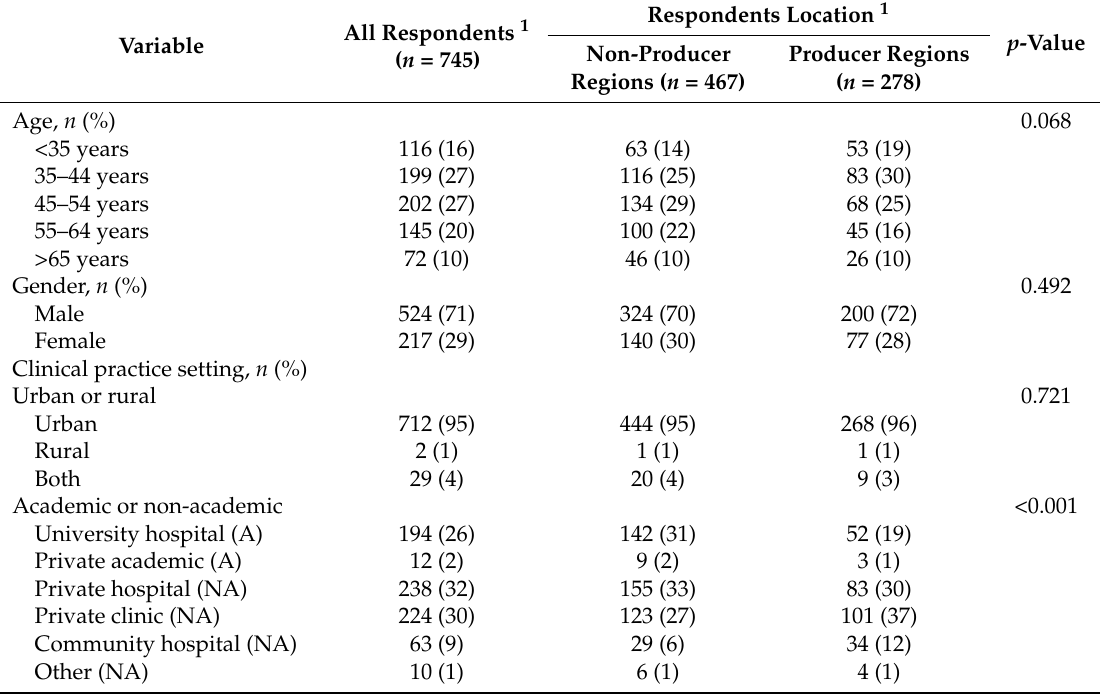
Table 1. Demographic and clinical practice characteristics stratified by regional location of the physicians’ clinical